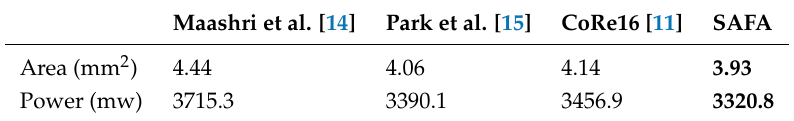
Table 2. Area and power evaluation for SAFA and other reconfigurable accelerators (28 nm). As can be seen, SAFA obtains the lowest power and area compared with the rest of the reconfigurable accelerators.